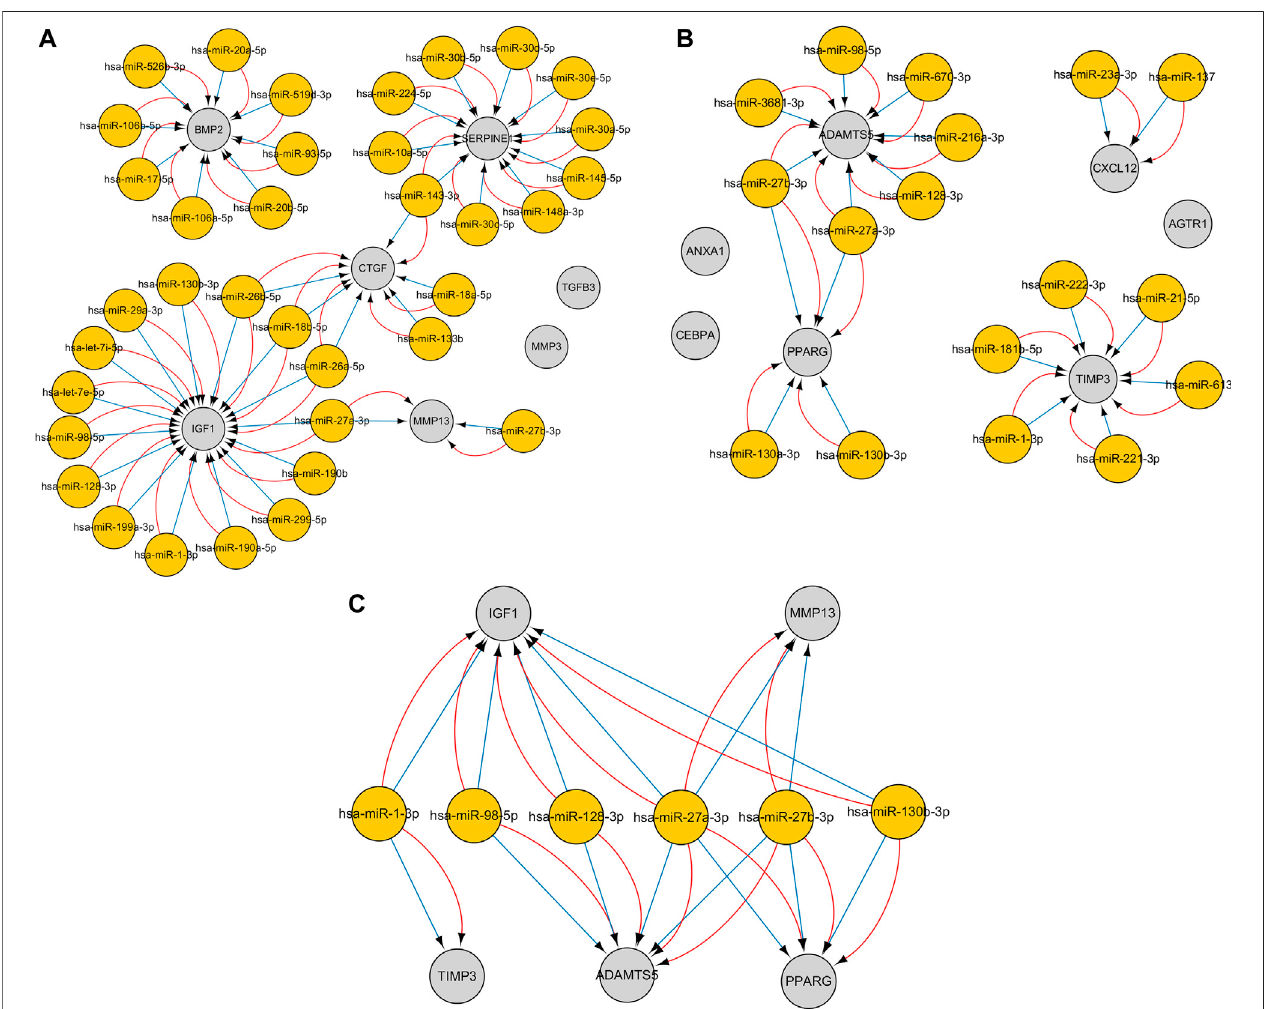
FIGURE 7 | The miRNA – gene interaction networks for the top seven hub genes of the upregulated and downregulated genes were constructed. An overlap threshold was used to display only microRNA – target interactions (MTIs) in two regulatory interaction networks. Genes are indicated by gray circles, and miRNAs are indicated by yellow circles. Blue edges represent MTIs from the TargetScan v7.2 database, and red edges represent MTIs from the MiRTarBase v8.0 database. (A) MiRNA – gene pairs of the top seven hub genes of the upregulated genes. (B) MiRNA – gene pairs of the top seven hub genes of the downregulated genes. (C) Six miRNAs (hub miRNAs) coregulate two osteogenic genes and three adipogenic